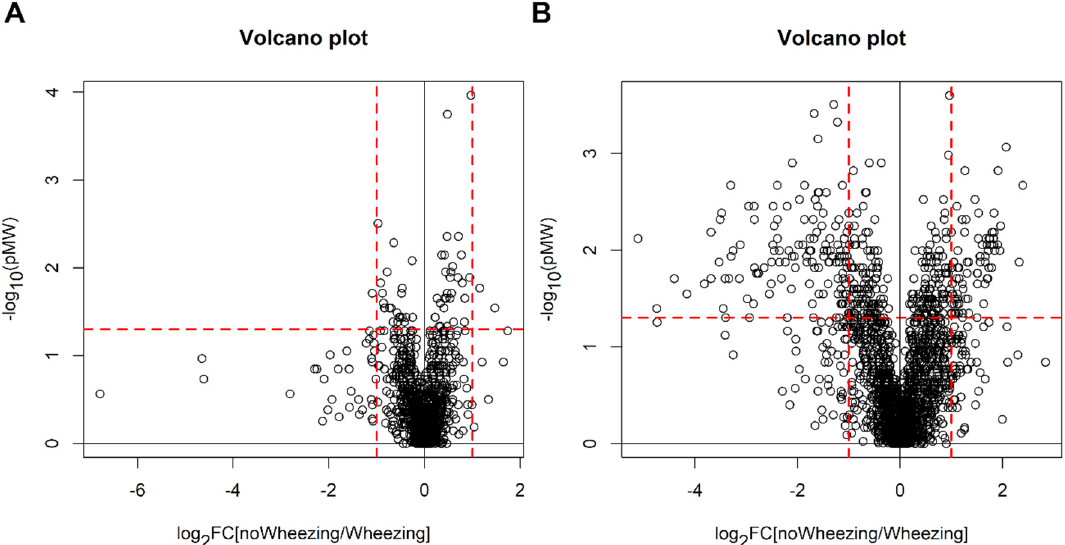
Figure 5. Children without bronchiolitis with or without recurrent wheezing: Volcano plots obtained for the POS dataset (panel ( A )) and for the NEG dataset (panel ( B )); the dashed red lines indicate the limits of p Mann-Whitney (pMW) equal to 0.05 and |log 2 FC| = 1.